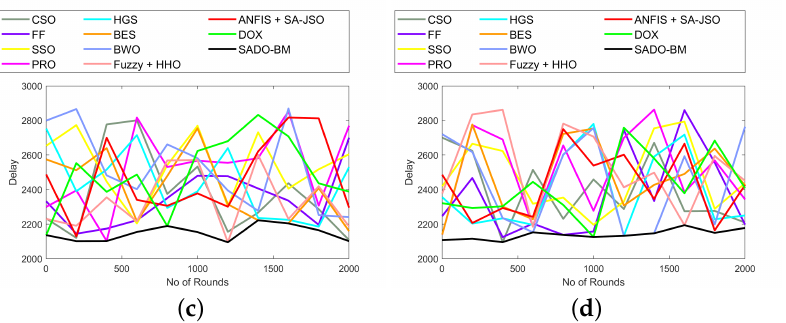
Figure 5. Delay analysis of SADO-BM over other models for node counts ( a ) 100, ( b ) 250 ( c ) 750, and ( d ) 1000.